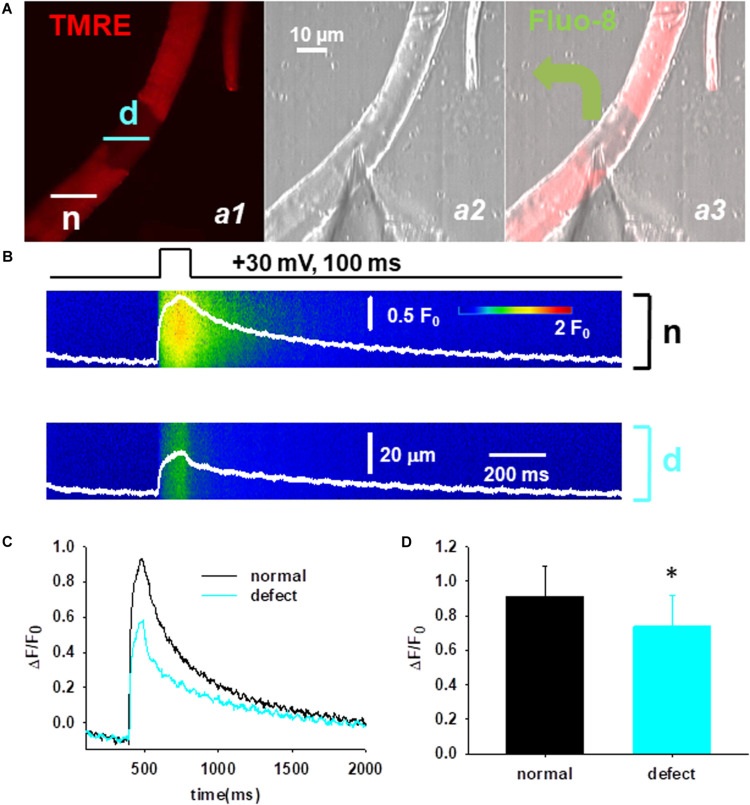
Functional defects of mitochondria in Cmpt fibers. (A) Cmpt fibers were first loaded with TMRE to identify the fiber segment with depolarized mitochondria (panel a1). n denotes the fiber segment displaying normal mitochondrial membrane potential; d depicts the fiber segment with depolarized or defective mitochondria. The patch pipette was placed at the interface of the regions (panel a2). Fluo-8 diffused into the fiber through the pipette (panel a3). The pipette solution contained 10 mM EGTA. (B) Simultaneous imaging of Ca2+ transients of fluo-8 fluorescence in the normal (n) and defective (d) areas during a depolarizing pulse (top). (C) Ca2+ transients reported by normalized fluo-8 fluorescence changes (F/F0), in the region with normal mitochondria (black), and in the region with depolarized mitochondria (cyan). Note the depressed Ca2+ transients in the area with defective mitochondria. (D) Averaged ΔF/F0 in the fiber region with or without defective mitochondria (n = 10 cells, N = 3 mice) ∗p < 0.05.